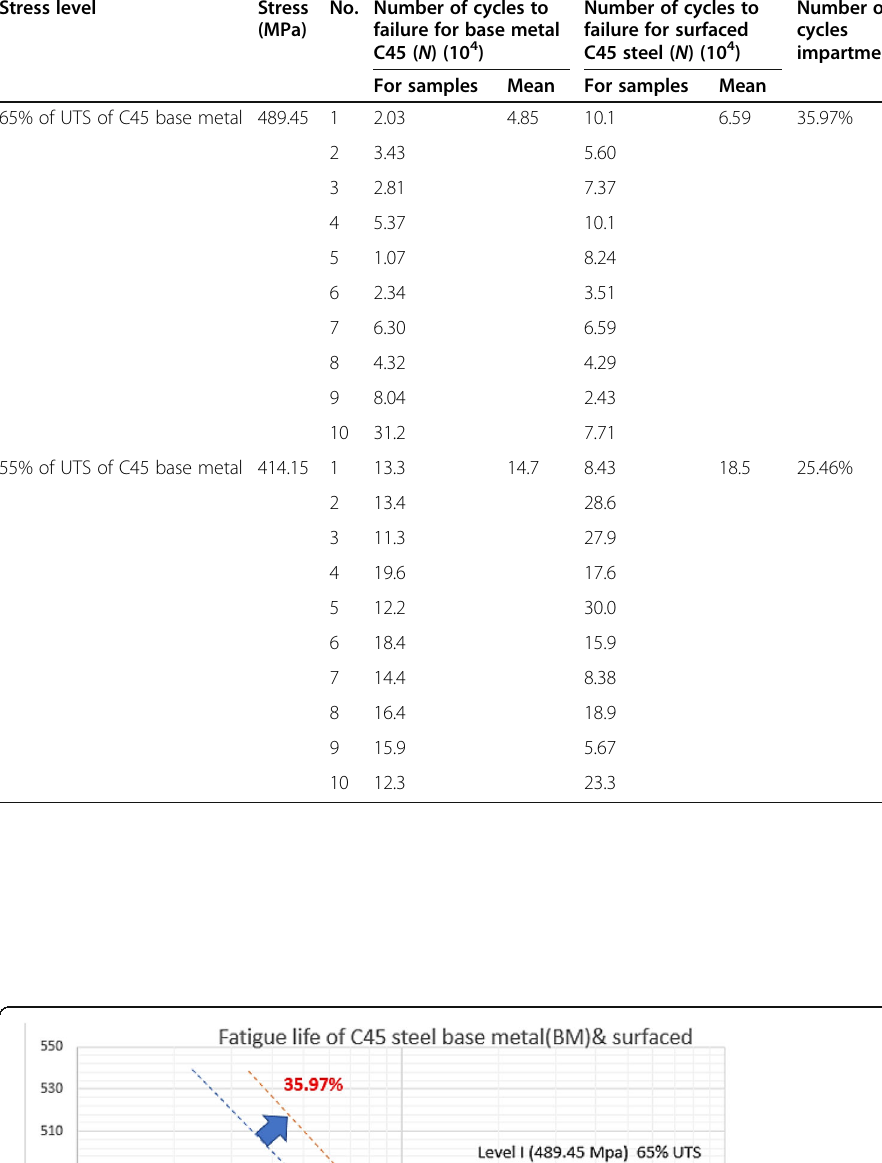
Table 5 Fatigue test results of C45 steel (BM and surfaced) Stress level